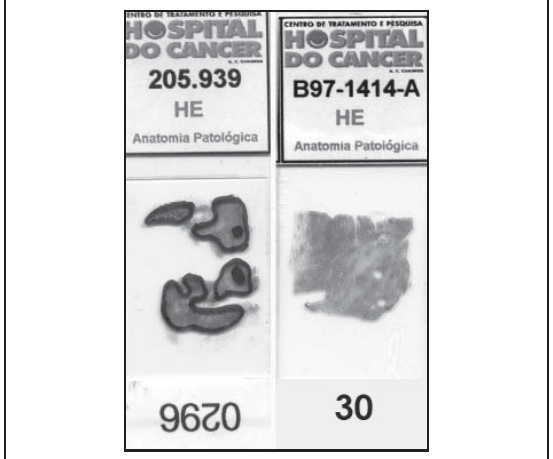
Figura 2 – Esquerda: lâmina obtida a partir do bloco original, com a área selecionada para a doação ao bloco receptor. As marcas podem ser amplas ou pontuais para orientar o técnico na obtenção do cilindro. Direita: lâmina obtida a partir do bloco doador após a retirada de dois cilindros de 1 mm cada para o controle de qualidade da área amostrada. Os números no extremo inferior da lâmina se referem à ordem do caso no bloco